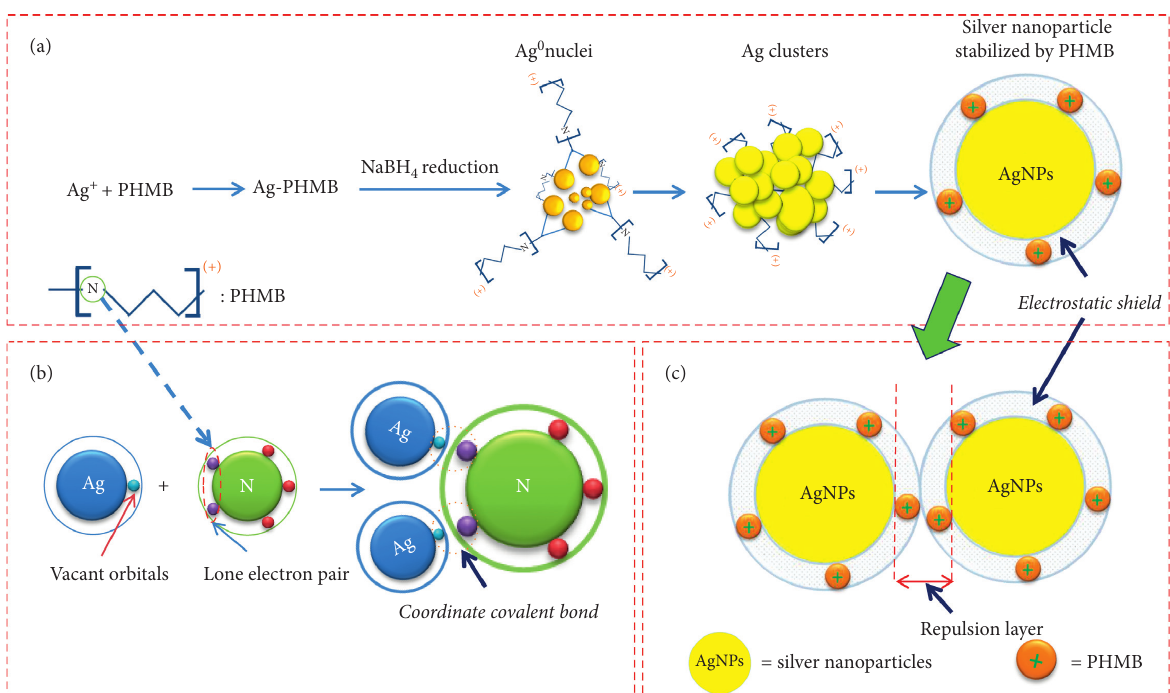
Figure 5: Schematic representation of AgNPs/PHMB: (a) NaBH + to AgNPs in the presence of PHMB; (b) the formation of 4 reduction Ag the coordinate covalent bond between silver metal atoms (Ag 0 ) and free-covalence electron pairs of the nitrogen (N) atom in PHMB molecules; and (c) mechanism stabilization of the AgNPs/PHMB via repulsion force AgNPs/PHMB particles.